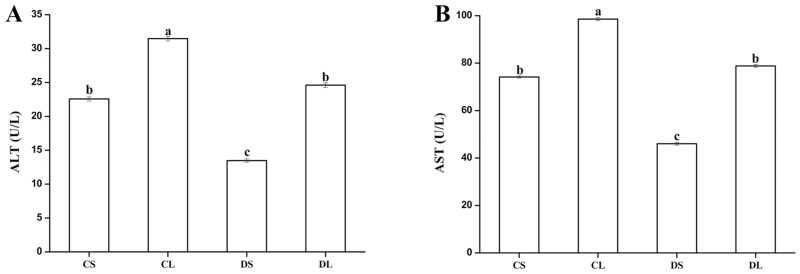
Effects of DMG-Na on ALT (A) and AST (B) activities in LPS-injected mice serum.Values are mean ± SEMs (n = 10). Mean of a variable without a common letter differ, P < 0.05. Alanine aminotransferase (ALT); Aspartate aminotransferase (AST). CS, gastric intubation in mice with 0 mg DMG-Na/0.3 ml sterile saline solution for 28 days and intraperitoneal injection with 100 μg/kg body weight of sterile saline solution at 29 day; CL, gastric intubation in mice with 0 mg DMG-Na/0.3 ml sterile saline solution for 28 days and intraperitoneal injection with 100 μg/kg body weight of LPS at 29 day; DS, gastric intubation in mice with 12 mg DMG-Na/0.3 ml sterile saline solution for 28 days and intraperitoneal injection with 100 μg/kg body weight of sterile saline solution at 29 day; DL, gastric intubation in mice with 12 mg DMG-Na/0.3 ml sterile saline solution for 28 days and intraperitoneal injection with 100 μg/kg body weight of LPS at 29 day.